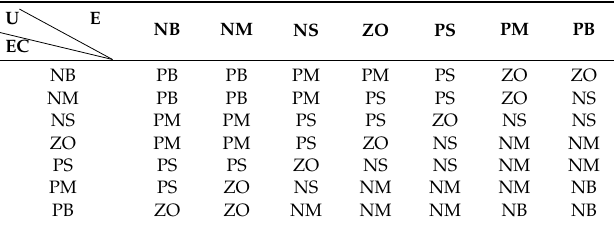
Table 4. Fuzzy control strategy for louver sieve